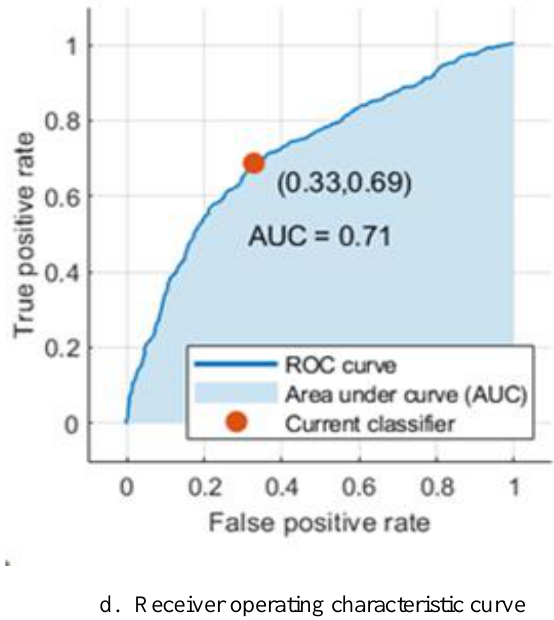
Fig. 2. SVM hyperparameter tuning for classification of MI based on work interference